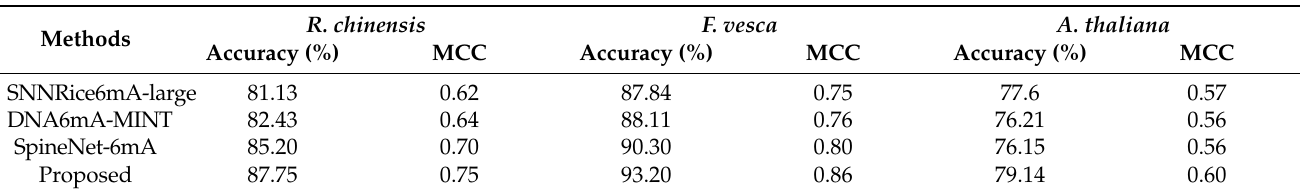
Table 2. Cross-species performance comparison between ENet-6mA and other state-of-the-art-models on R. chinensis , F. vesca , and A. thaliana